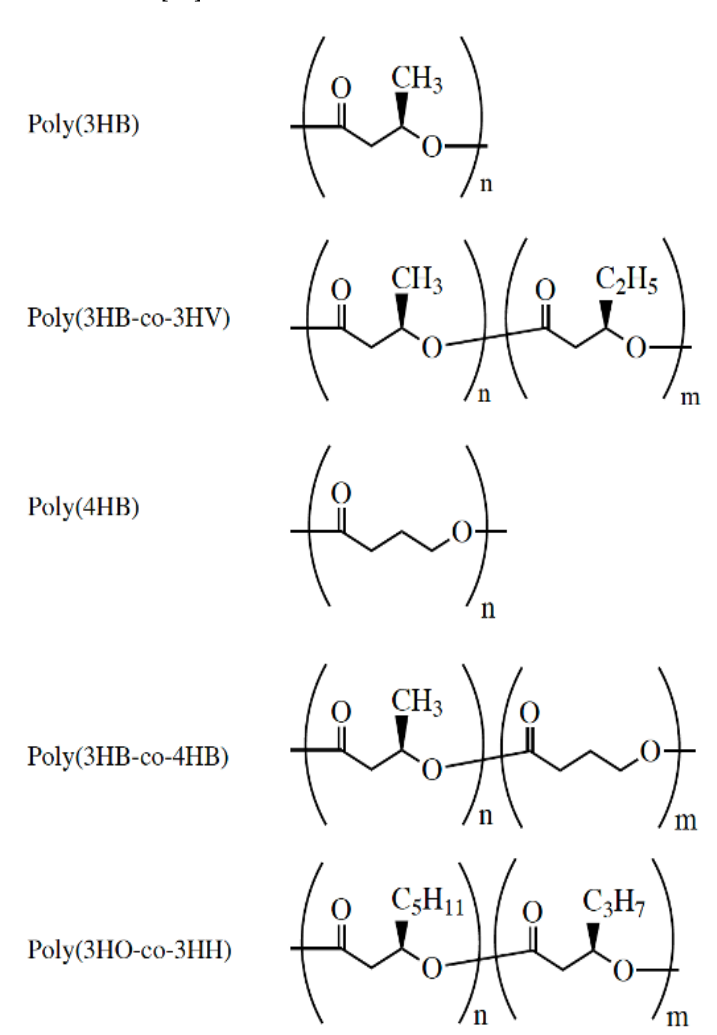
Figure 2. Chemical structure of PHAs under medical investigation. Reused from [37] with kind permission of John Wiley and Sons.